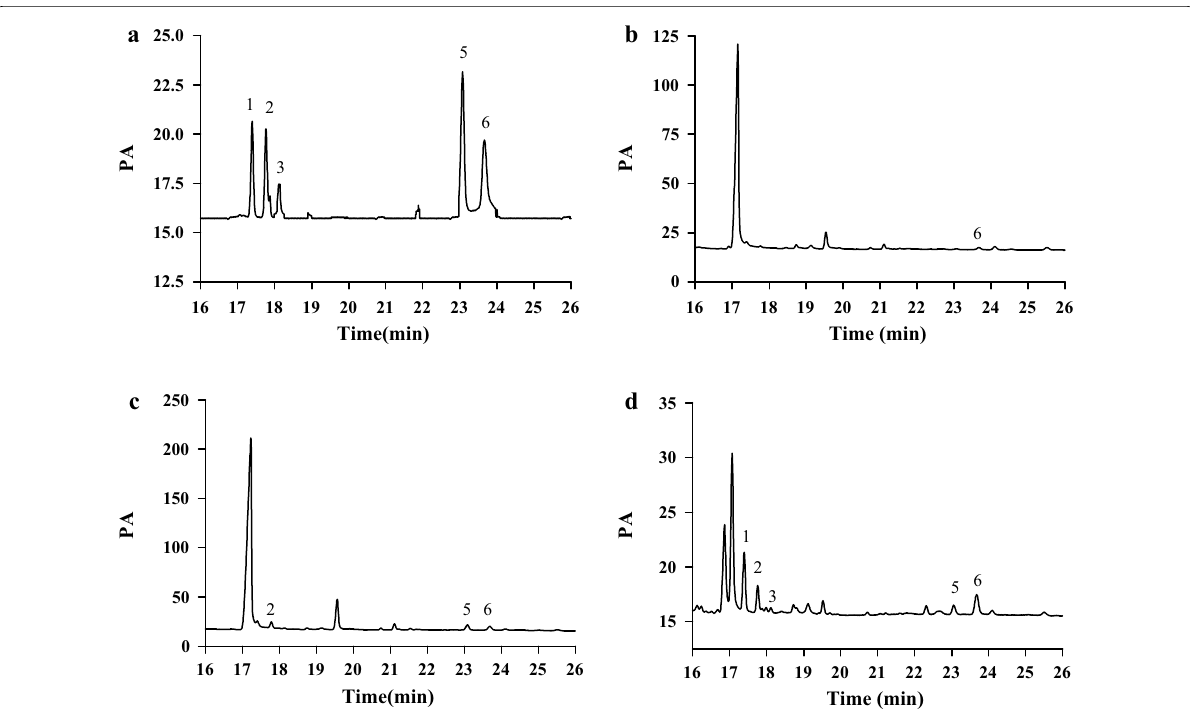
Fig. 4 Gas chromatograms of the monosaccharide compositions of polysaccharides LLp-1a ( a ), LLp-1b ( b ), LLp-2 ( c ) and LLp-3 ( d ) from L. lucidum